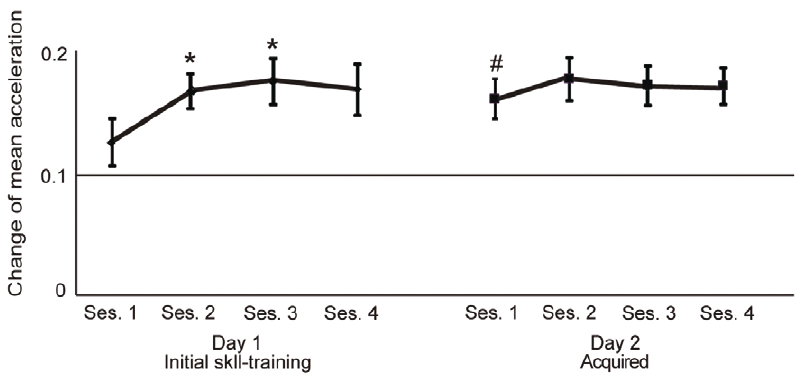
Figure 2. Mean acceleration changes in initial skill-training and acquired conditions. In initial skill-training, the mean accelerations were significantly increased in sessions 2 and 3 compared with session 1, whereas the mean acceleration in session 4 did not reach statistical significance. For the baseline, t -testing revealed a significant increase in mean acceleration for session 1 in the acquired condition compared with initial skill- training. In the acquired condition, no additional gains in acceleration were observed in sessions 2–4. Y axis indicates the ratio of mean accelerations compared with baseline of session1 on Day 1. Error bars show the SEM. * P , 0.05, # P , 0.01.